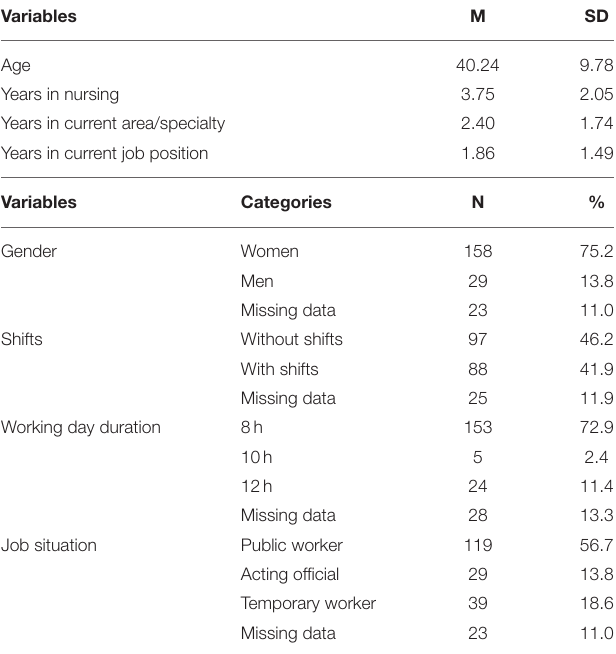
TABLE 2 | Characteristics of the